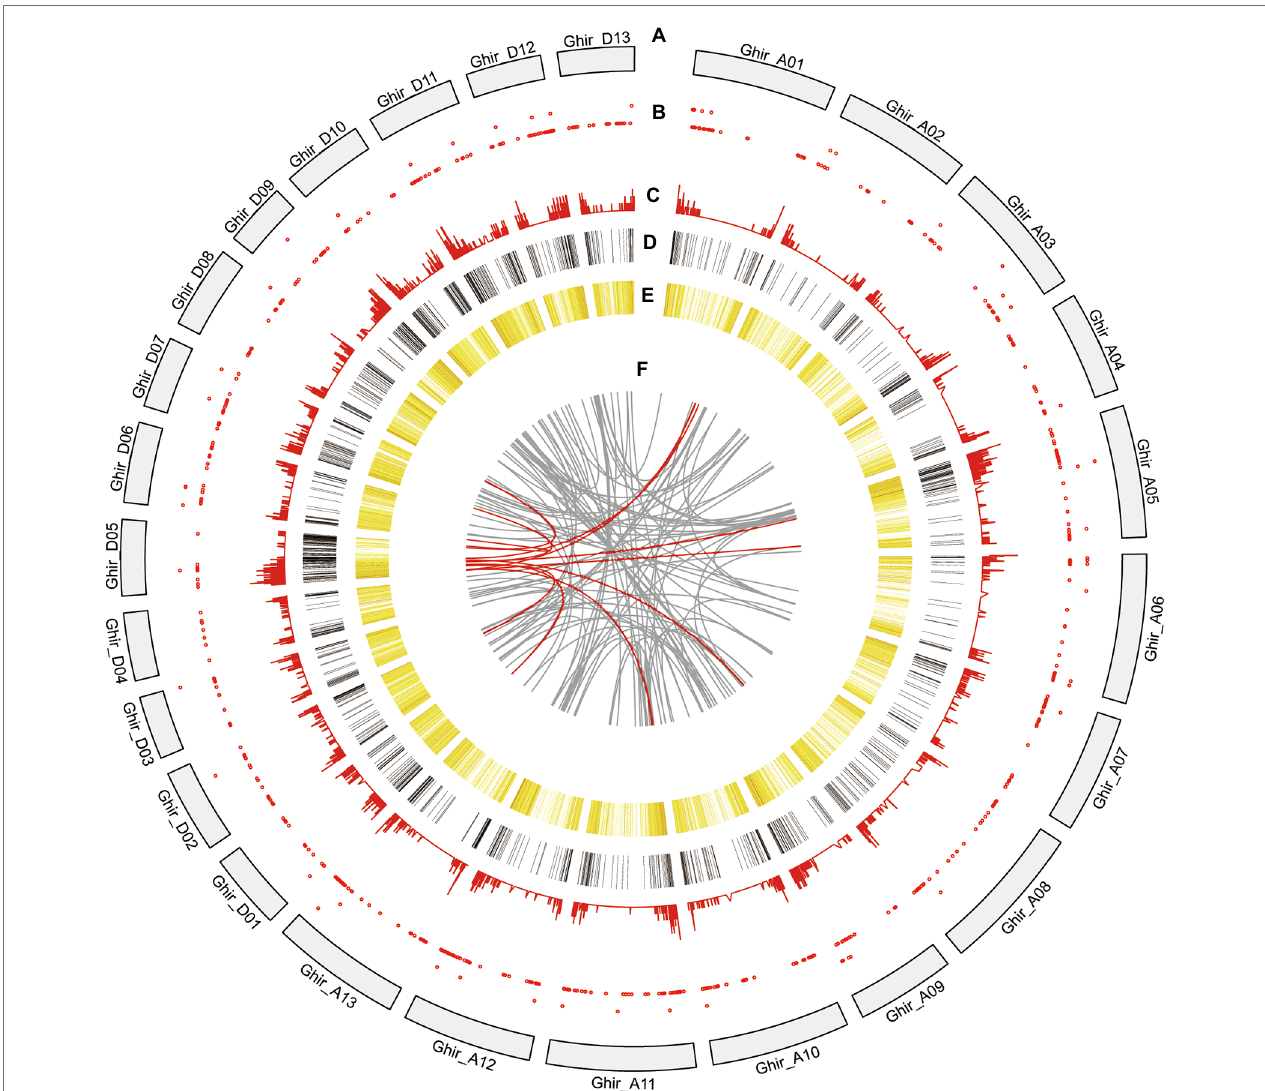
FIGURE 4 | Circos visualization of the PacBio Sequel platform at genome-wide level. (A) Twenty-six chromosomes distribution of G. hirsutum genome. (B) LncRNA density from the PacBio Sequel platform. The closer the red point is to the center, the lower the density. (C) APA sites distribution mapped to G. hirsutum genome. The closer the line is to the center, the lower the density. (D) DEGs of R line compared with A line and B line. The closer the color is to red, the higher the density. Conversely, the closer the color is to black, the lower the density. (E) Novel isoforms density from the PacBio Sequel platform. The closer the color is to red, the higher the density. Conversely, the closer the color is to yellow, the lower the density. (F) Fusion transcripts distribution. Red line represents fusion transcripts which are involved in the D05